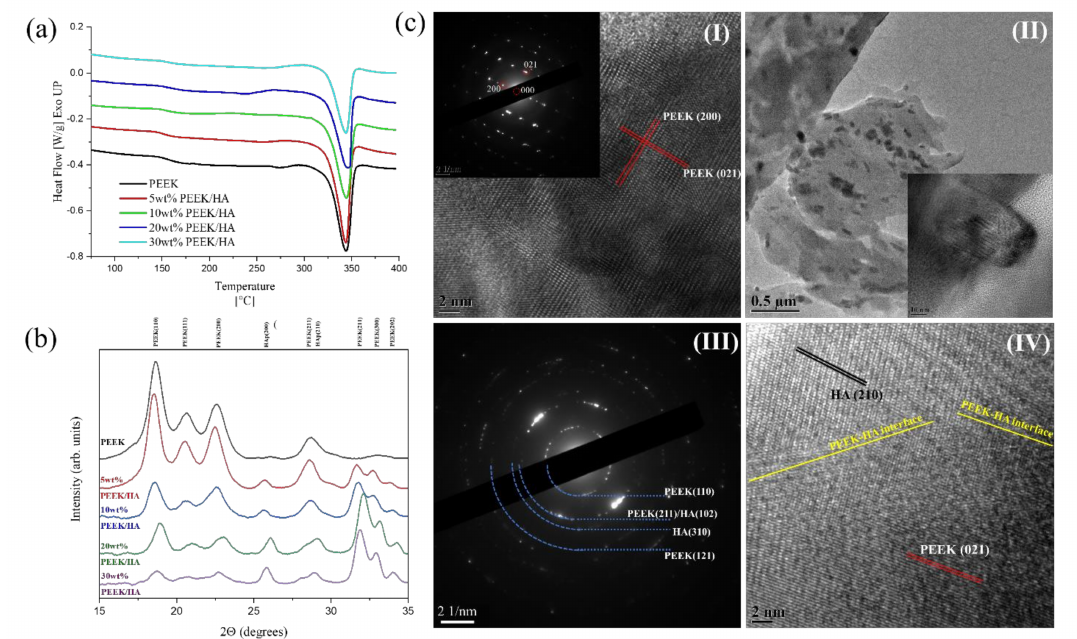
Figure 4. ( a ) First heating scan of DSC 3DP specimen, ( b ) XRD pattern of 3DP samples with various HA content and ( cI ) HRTEM image and corresponding SAED pattern from PEEK, ( cII ) TEM image of 30 wt% PEEK/HA composite, inset showing a HA particle on the surface of PEEK, ( cIII ) The SAED pattern corresponding to Figure ( cII ) and ( cIV ) HRTEM of 30% PEEK/HA showing the lattice fringes corresponding to PEEK and